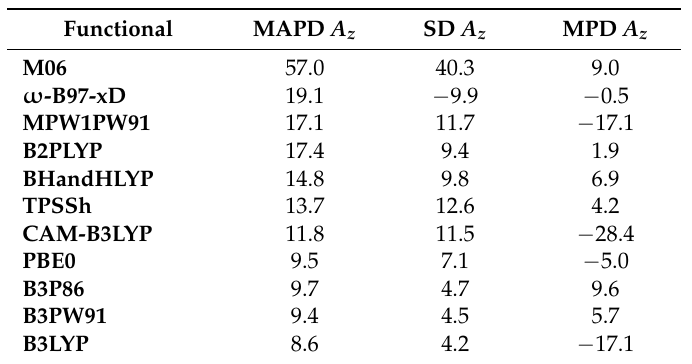
Table 2. Mean absolute percent deviation (MAPD) and mean percent deviation (MPD) from the experimental value A z of the fourteen Cu(II) complexes, and standard deviation (SD) as a function of the functional 1